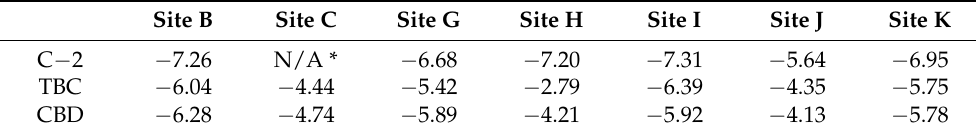
Table 1. The comparisons of docking scores of AMs in various allosteric binding sites (kcal/mol). Site B Site C Site G Site